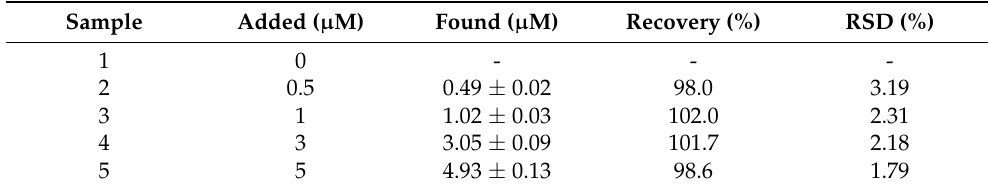
Table 2. The recoveries of the TiO 2 -MXene/PEDOT:PSS/GCE in urine samples ( n = 5).